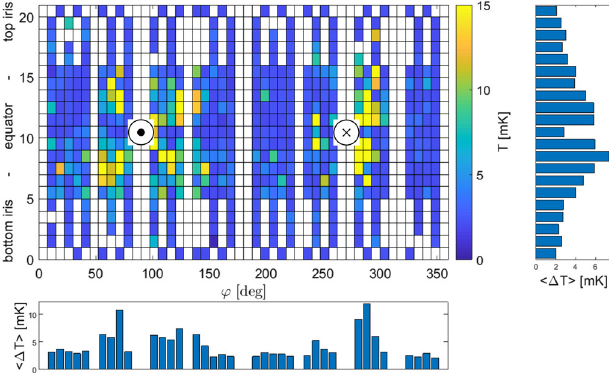
FIG. 9. Temperature map of baseline measurement without any externally applied field. Data is recorded at 1.8 K, and ¼ 15 MW = m. The quality factor is Q E acc visualization of hot spots, bar charts are added to the bottom, and right-hand side of each temperature map in Figs. 9 – 12 illustrating average temperatures of each row, or column, respectively. In Figs. 10 – 12 temperature maps show hot spots.